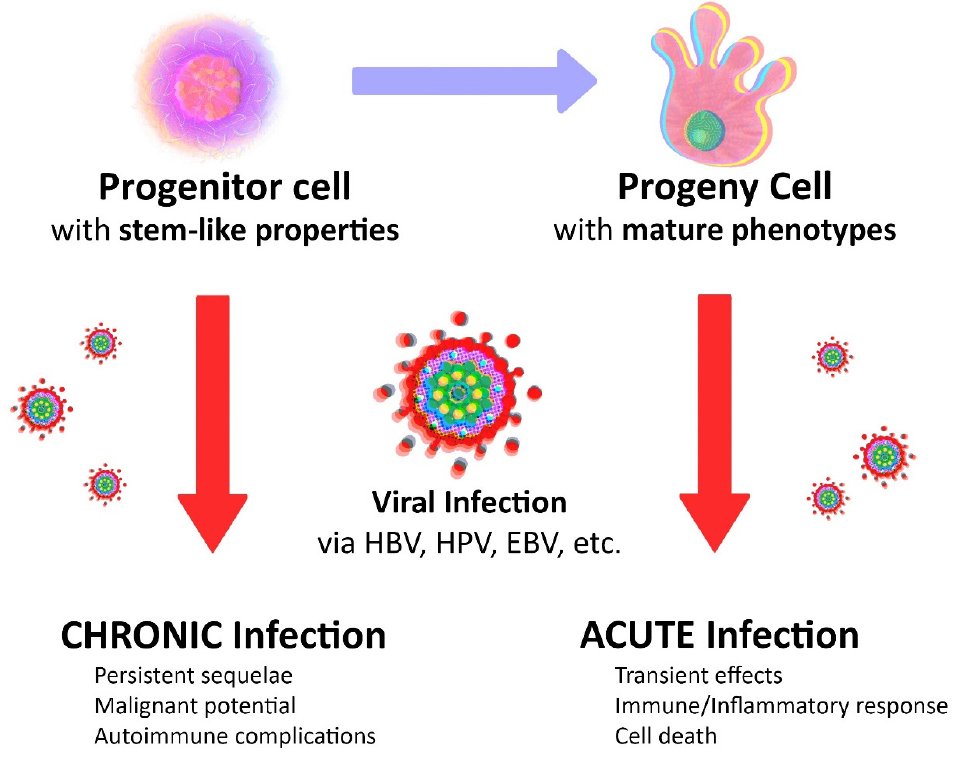
Figure 1. Viruses and cancer. A virus is more likely to cause malignant tumors, chronic infections, and autoimmune com- plications when it infects a progenitor cell with stem-like properties rather than a progeny cell with mature phenotypes (illustrated by Benjamin